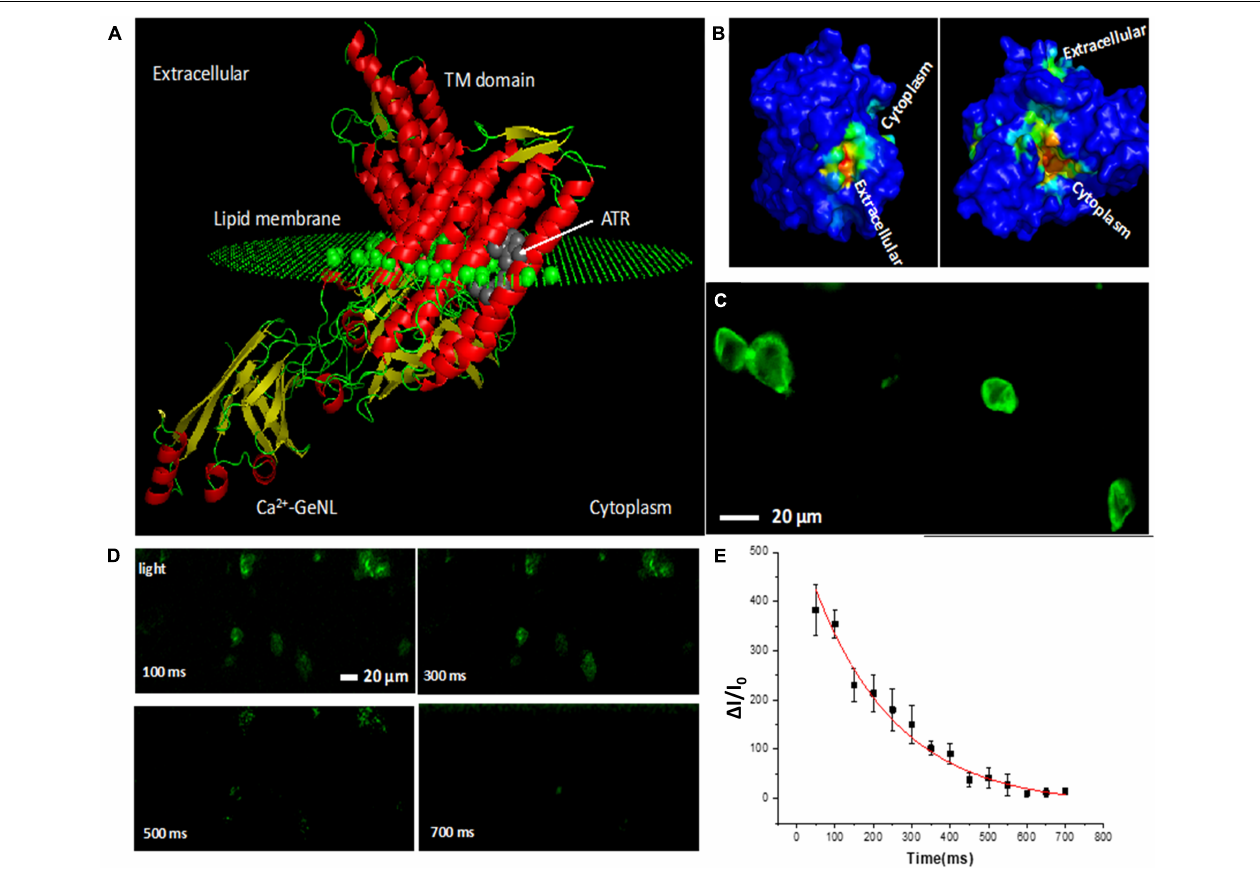
FIGURE 1 | Modeling of bioluminescence multi-characteristic opsin (bMCOII) molecule, its expression, and functional characterization of Ca 2 + -bioluminescence in HEK293 cells upon light stimulation. (A) Three-dimensional structure of bMCOII in a lipid layer from homology modeling and molecular dynamics simulation along with bound ATR molecule (using Autodock 4). (B) Channel openings and cavity of the transmembrane bMCOII actuator domain as determined by simulation. (C) Confocal fluorescence image showing the expression of bMCOII in HEK293 cells. (D) Time-lapse change in Ca 2 + bioluminescence ( (cid:49) I/I 0 , in%) from bMCOII-sensitized cells at various time points after light stimulation. (E) Temporal decay profile of Ca 2 + bioluminescence signal with half-life of 216 ± 25 ms. N = 10 stimulations. Av. ±